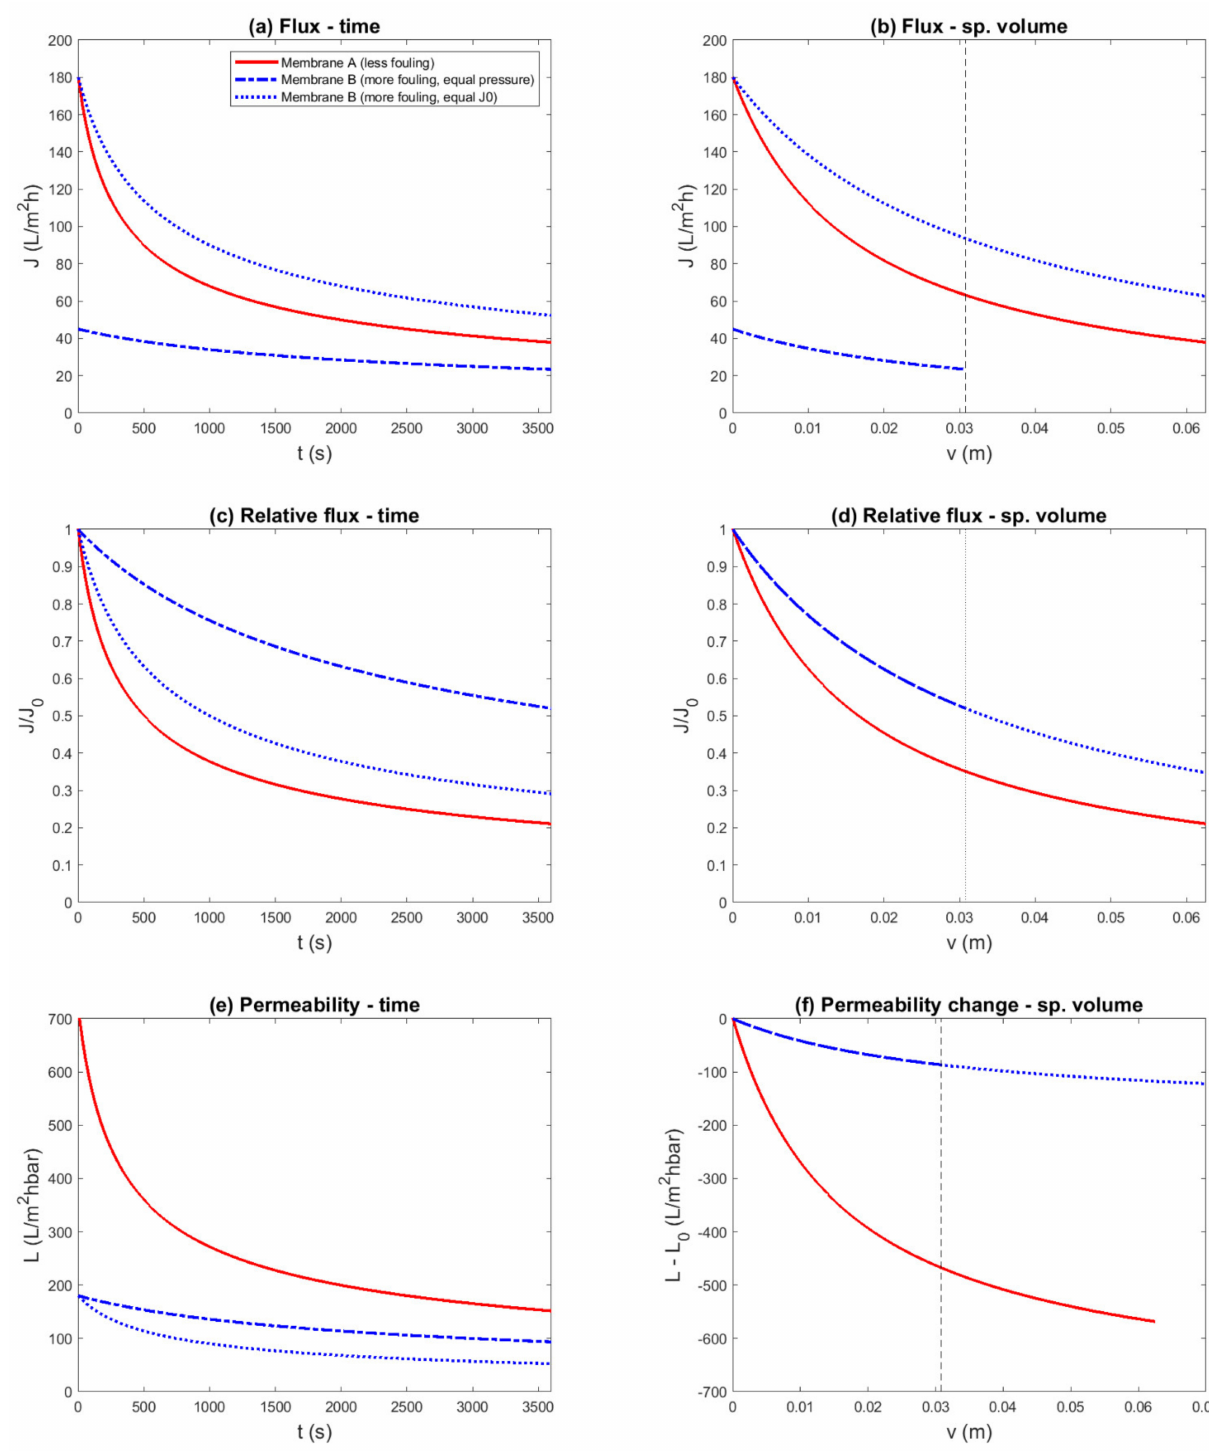
Figure 1. Simulated constant-pressure experiment, aiming to compare two membranes with equal transmembrane pressure (0.25 bar) and equal initial flux (TMP B = 1 bar), and several flux- and permeability-based data representations. The example was constructed such that membrane A was superior to membrane B, due to both a lower membrane resistance ( R MA = 0.5 × 10 12 m − 1 vs. R MB = 2.0 × 10 12 m − 1 ) and a lower fouling rate ( α A = 3.0 × 10 13 m − 2 vs. α B = 6.0 × 10 13 m − 2 ). Different representations ( a —Flux–Time; b —Flux–Specific Volume; c —Relative Flux–Time; d —Relative Flux–Specific Volume; e —Permeability–Time; f —Premeability Change–Specific Volume) were comp—red to evaluate if the known difference in fouling propensity was reflected: ( c , d , f ) suggest a conclusion contradicting the underlying